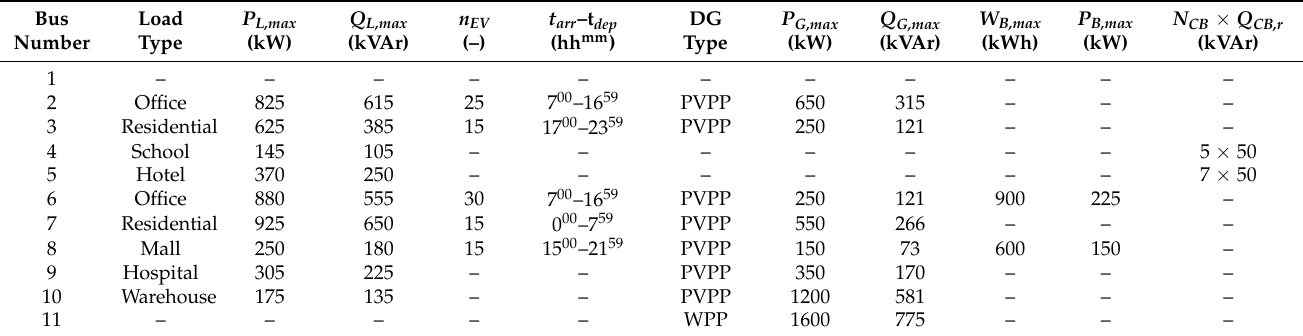
Figure 2. One-line diagram for the considered microgrid. Table 1. Microgrid